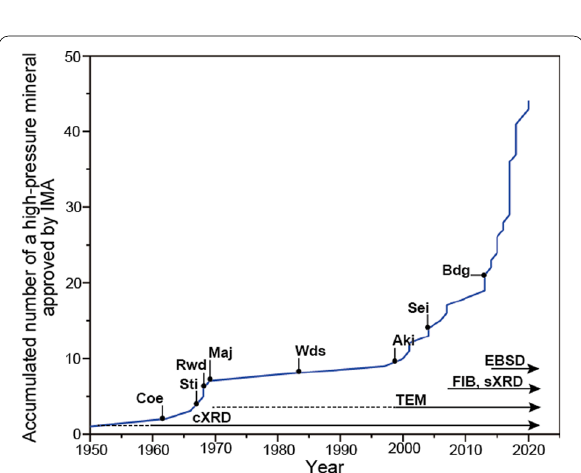
Fig. 2 The accumulated number of a new high-pressure mineral by year. The discovery of major minerals is shown in the figure.